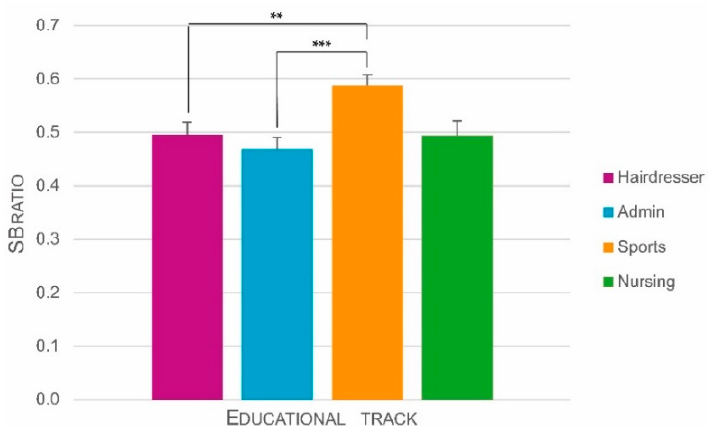
Figure 4. Differences between educational tracks in sedentary behavior (SB)-ratio controlled for age, sex, and fat percentage. Error bars are standard errors. Significant Bonferroni corrected pair-wise comparisons are indicated with asterisks (** = p < 0.01; *** = p < 0.001).